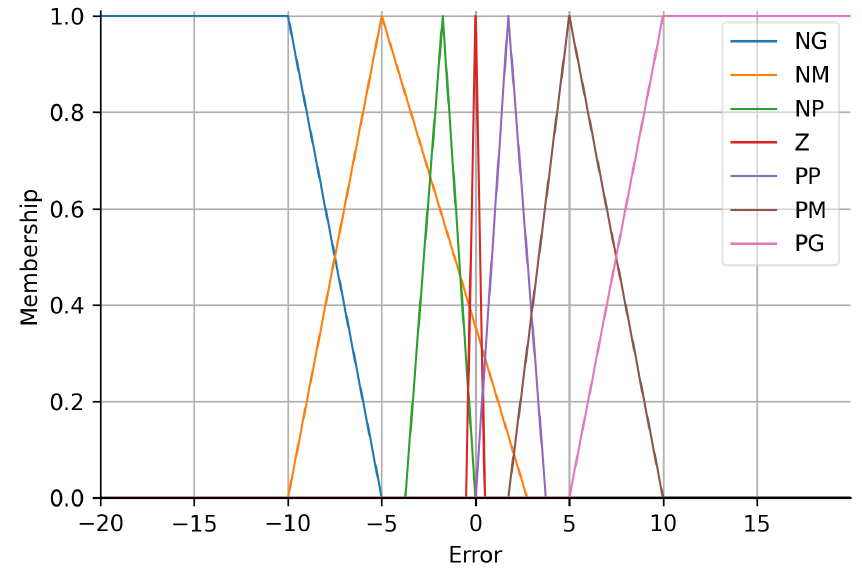
Figure 3. Membership function of the error of variation input variables (input